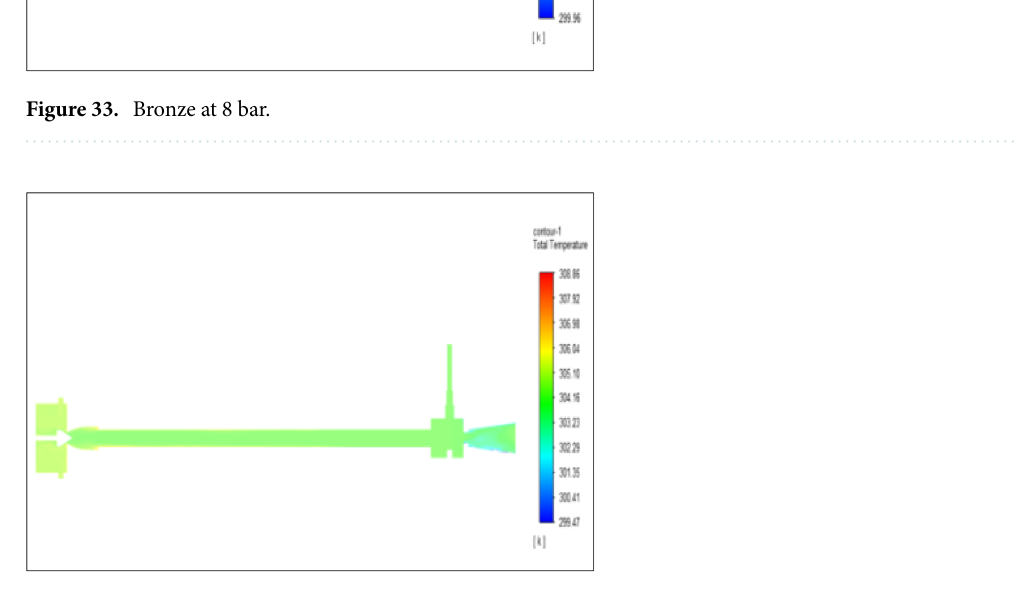
Figure 34. Copper at 8